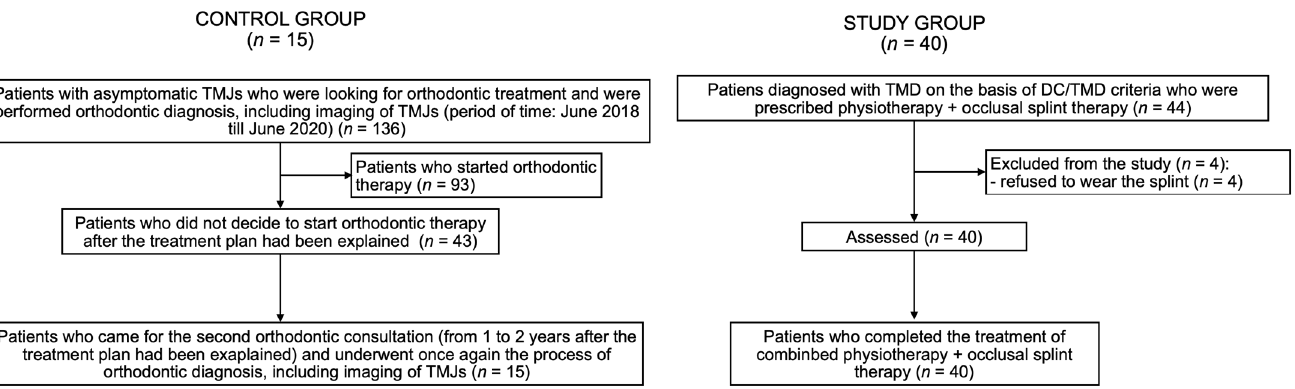
Figure 3. Flow of the participants during the study. DC/TMD—diagnostic criteria for temporomandibular joint disorders; TMJ—temporomandibular joint; TMD—temporomandibular joint disorders.